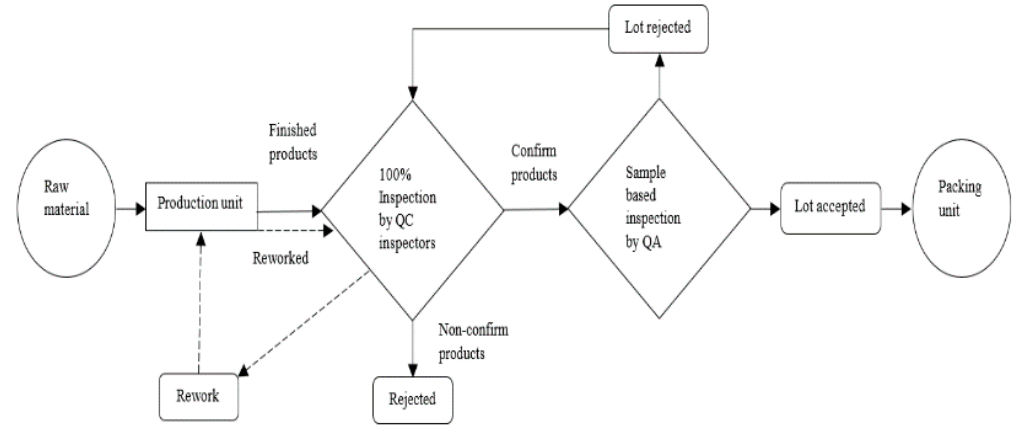
Figure 1. Flowchart of production unit and inspection stations of a manufacturing system.